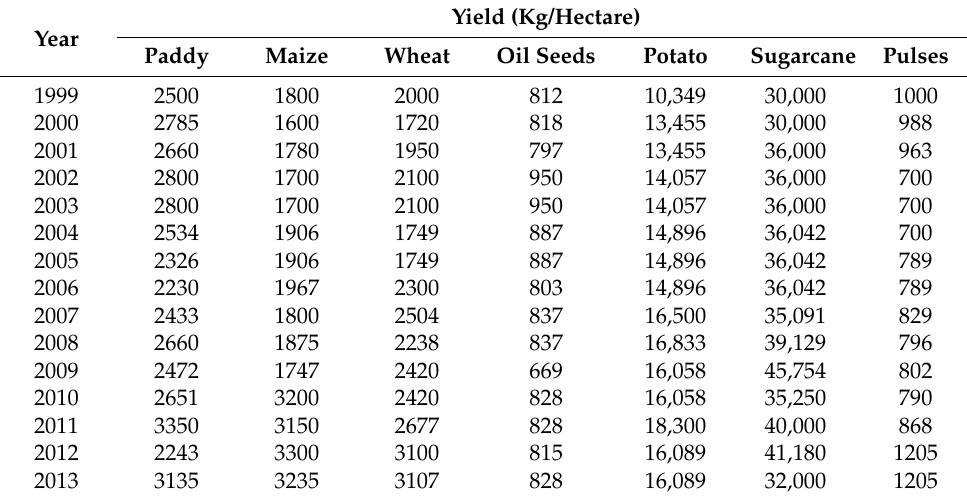
Table 10. Yearly yield of major crops grown in the study area (data generated from [27]).